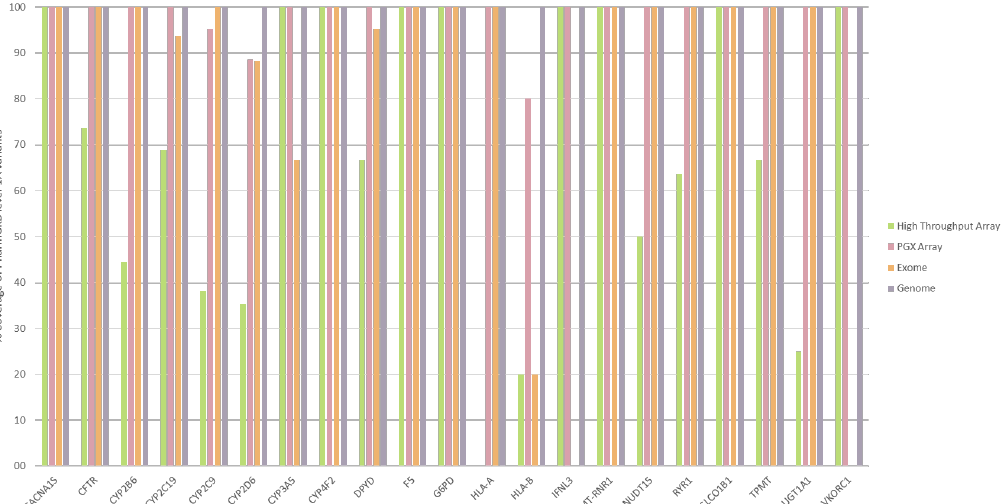
Figure 4 . Coverage comparison of PharmGKB level 1A variants between different pharmacogenetic (PGx) diagnostic techniques. Percentage of coverage of the main PGx variants (PharmGKB level 1A variants) for the 21 main PGx genes (those associated with PharmGKB level 1A variants) is plotted for 4 PGx diagnostic techniques: standard high-throughput array (green), high-throughput array with enhanced PGx content (pink), whole-exome sequencing (orange) and whole-genome sequencing (purple).